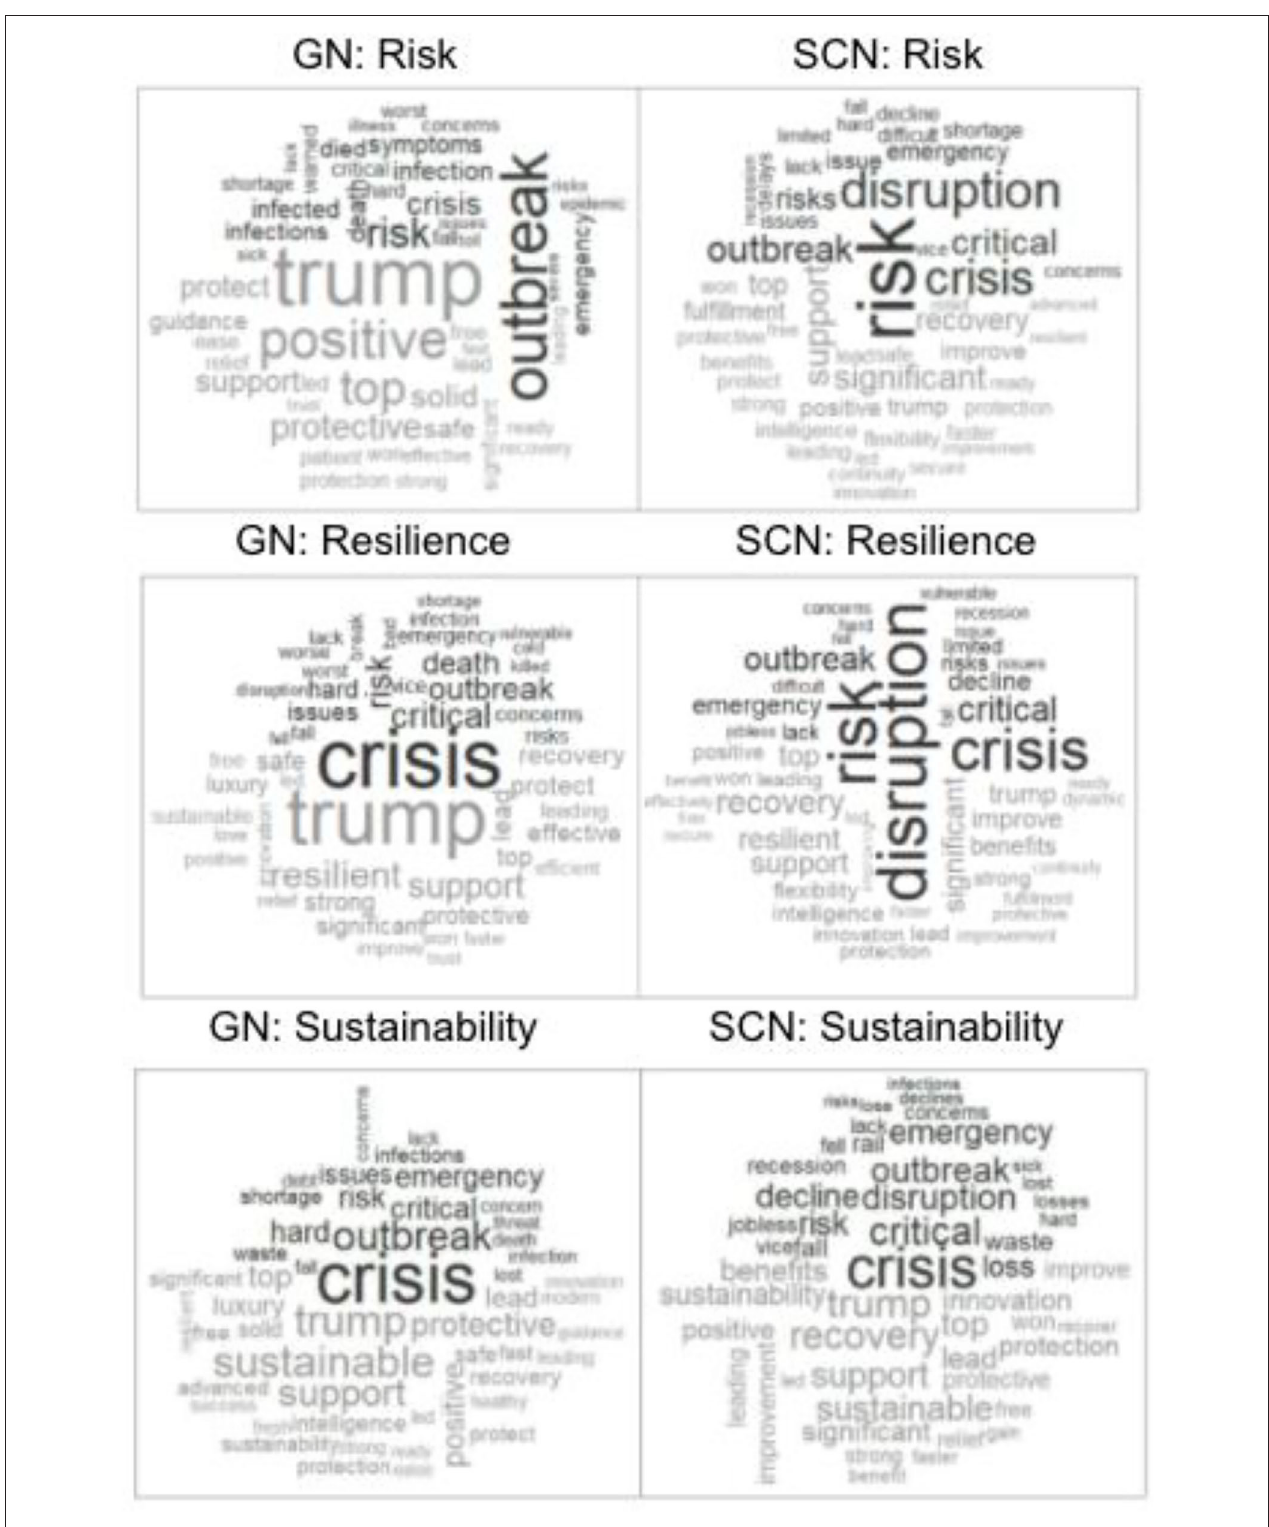
FIGURE 9 | Word cloud with sentiment containing supply chain management (SCM) constructs.